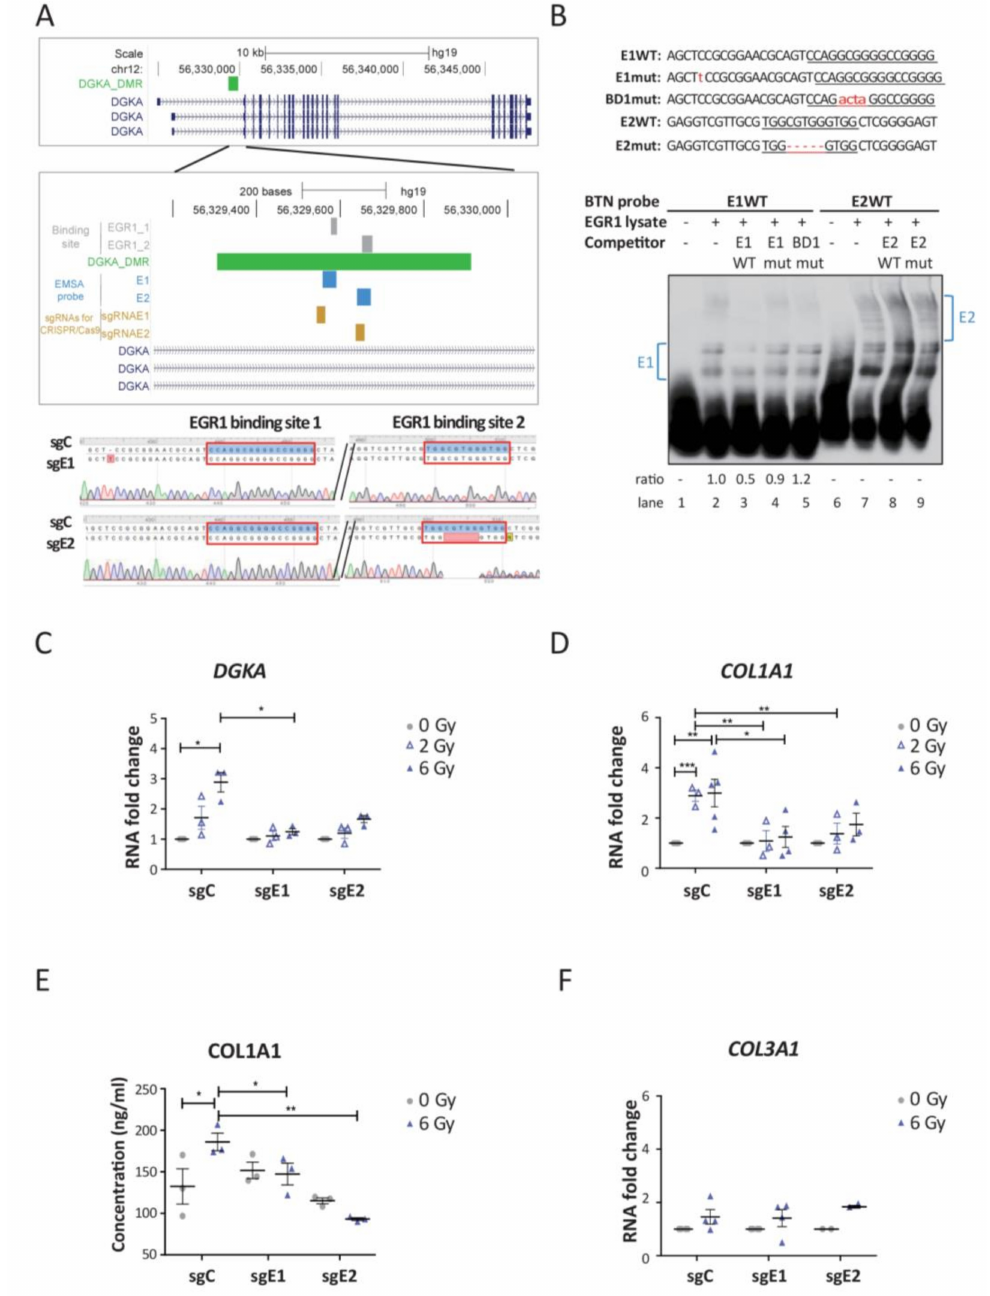
Figure 2. Loss of EGR1-binding at the DGKA enhancer suppresses the induction of DGKA and COL1A1 after irradiation. ( A ) Upper panel: map of the interrogated DGKA enhancer region in relation to DGKA transcripts. Zoom-in: indicates the two EGR1-binding sites (EGR1_1 and EGR1_2, gray), the differentially methylated region (DMR), regions for EMSA probes (E1 and E2, blue), two sgRNA targeting sites (sgRNAE1 and sgRNAE2; khaki), and DGKA transcripts (navy). Lower panel: DNA sequence analysis covering the two EGR1-binding sites (red boxes) in the DGKA enhancer. sgC indicates the sequence of control (wild type) sgRNA-treated cells. sgE1 and sgE2 indicate cells targeted with sgRNAE1 and sgRNAE2 at the first and the second EGR1-binding site, respectively. Mutations are highlighted in red. ( B ) Upper panel: sequences of probes used in EMSA. E1WT and E2WT probes contain the wild type sequence covering the first and the second EGR1-binding sites. E1mut probe contains a one-base pair insertion before the first EGR1-binding site as observed in sgE1 cells. BD1mut probe contains a GGCG to ACTA mutation directly in the first EGR1-binding site. E2mut probe contains a five-base pair deletion in the second EGR1-binding site as observed in sgE2 cells. Lower panel: EGR1 DNA-binding activity at the TF-binding sites measured by EMSA. Ratios indicated are based on the E1 or E2 band shifts highlighted with blue brackets. ( C , D )